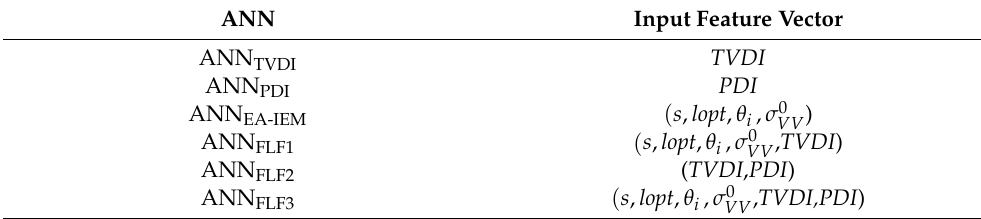
Table 2 clarifies the input vectors for each ANN. Table 2. Description of the input feature vectors of all of the used artificial neural